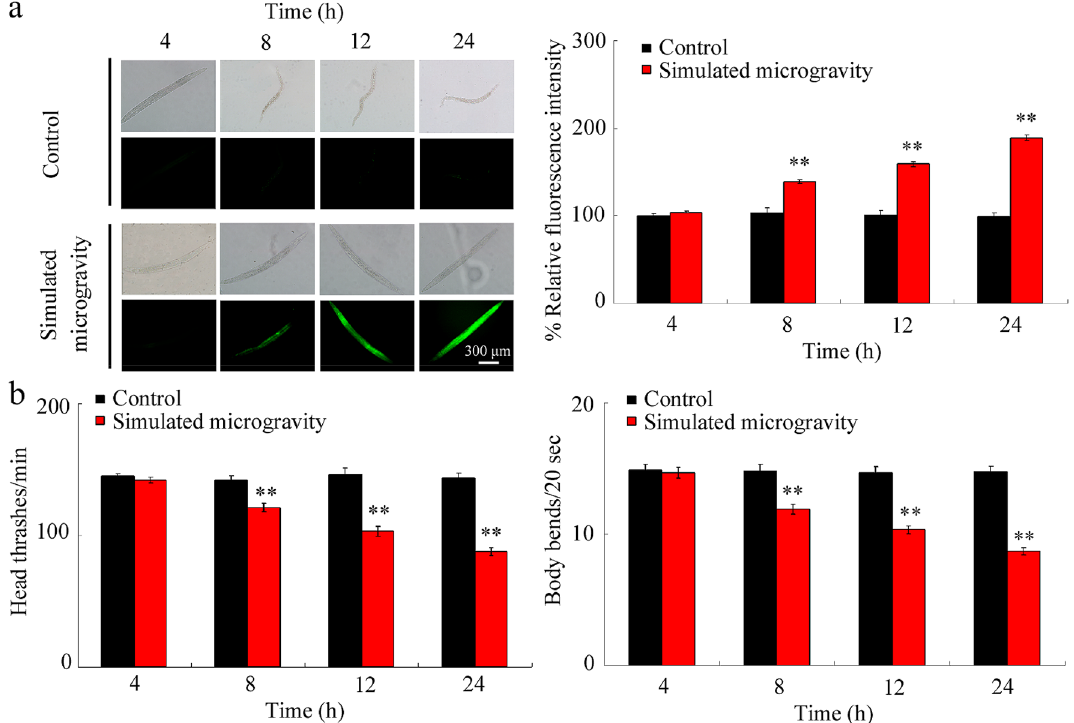
Figure 1. Effects of simulated microgravity treatment on wild-type nematodes. ( a ) Effects of simulated microgravity treatment on ROS production. N = 50. ( b ) Effects of simulated microgravity treatment on locomotion behavior. N = 40. Simulated microgravity treatment was performed in RCCS system at 30 rpm for 4, 8, 12, or 24 h. Bars represent means ± SD. ** P < 0.01 vs